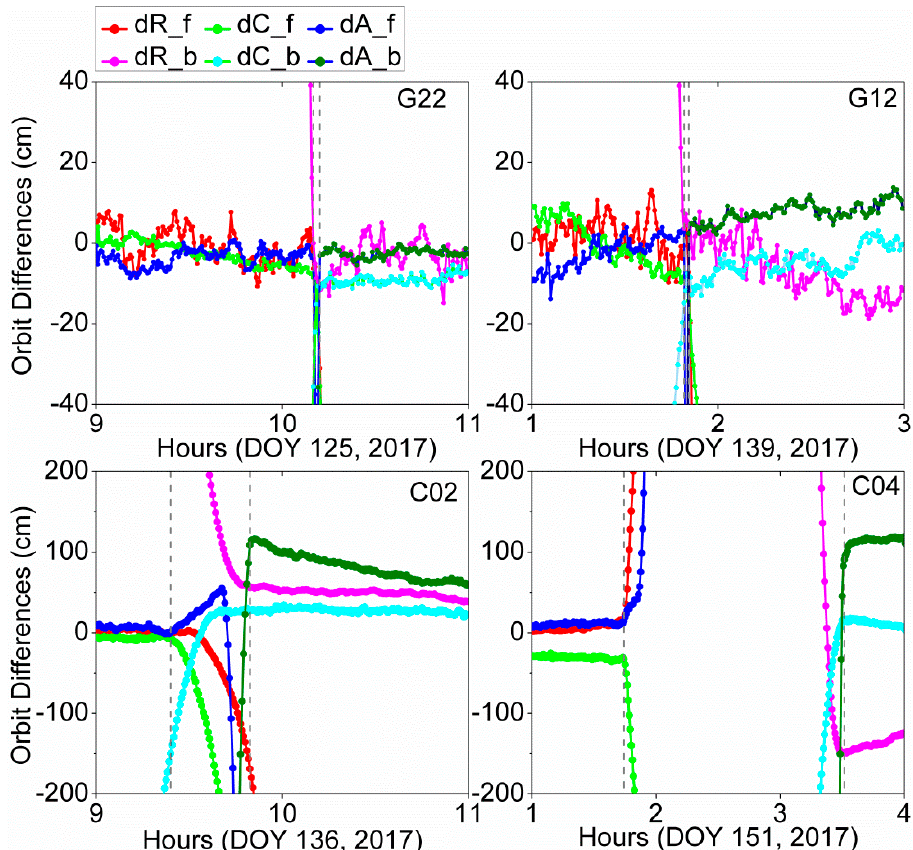
Figure 7. Orbit differences between the RPPP solutions and the forward and backward integration orbits for G22, G12, C02 and C04 around maneuvers. The vertical dashed lines indicate the detected start and end time of maneuver events.